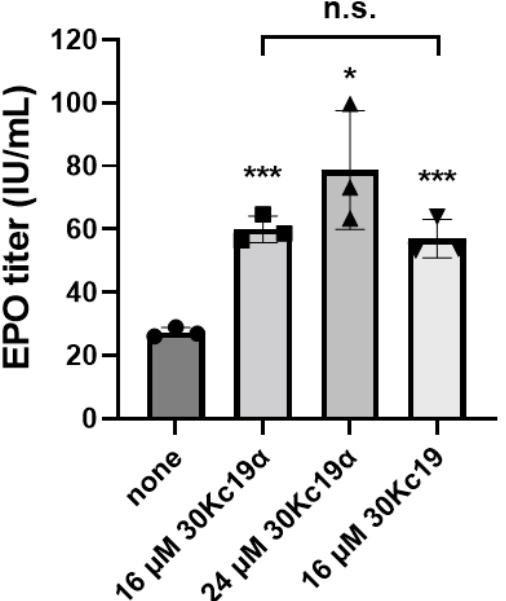
Figure 5. Comparison of effects of 30Kc19 α and full-length 30Kc19 on rhEPO production in CHO cells. Cells were dually treated with the indicated concentration of 30Kc19 α or 30Kc19, respectively. Subsequently, the conditioned media were collected on day 2 of culture in serum-free medium. Titers of rhEPO were determined by ELISA. Error bars indicate standard deviations ( n = 3 per group). Statistical significance was determined using Student’s t -test. *, p < 0.05; ***, p < 0.005 compared to the nontreated control; n.s., not significant in comparison between 30Kc19 α and 30Kc19-treated group.